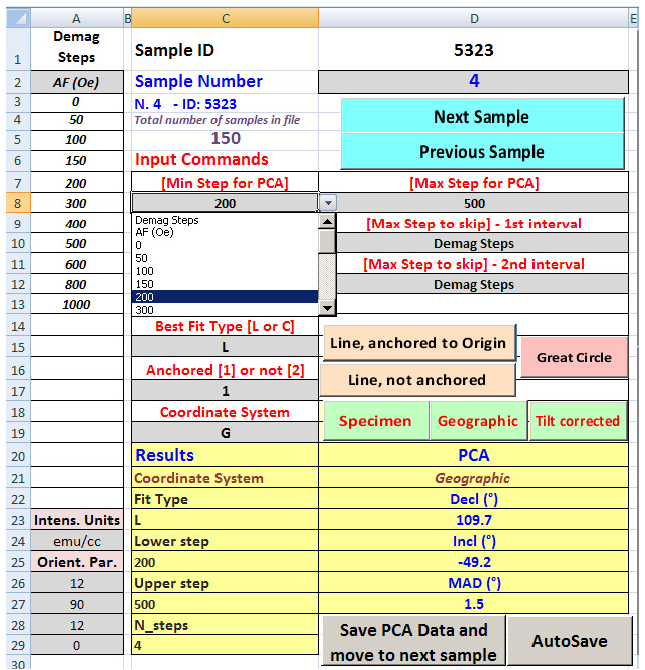
Figure 5. Cells and buttons associated with user choices in the Com- mands_plots worksheet. The figure illustrates the use of the drop-down menu in cell C8 to select the minimum step for PCA